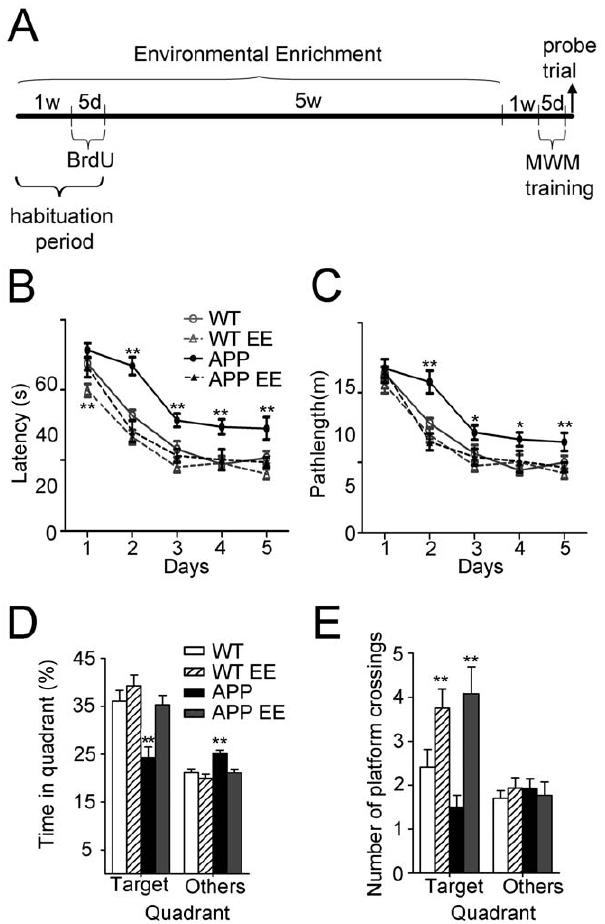
Figure 1. Short-term environmental enrichment improves learning and memory in young APP Sw,Ind mice. (A) The experimental design consisted of 7 weeks of environmental enrichment (EE), that included 5 days BrdU injections, and 1 week without enrichment followed by the Morris water maze (MWM). (B,C) The performance of WT (n=17), APP Sw,Ind (n=14) and 7 week-enriched WT (n=16) and APP Sw,Ind (n=14) mice at the age of 6 months improved significantly during the training days in the hidden version of the MWM, indicating that all groups were able to learn the task. Compared to WTs, APP Sw,Ind mice, but not enriched APP Sw,Ind mice, exhibited significantly longer latencies and pathlength from training day 2 to 5. (D) Percentage of time spent in the target and other quadrants during the probe trial on day 5 in the MWM. WT and APP Sw,Ind EE mice displayed significantly higher occupancy of the target quadrant relative to other quadrants ( p , 0.0001). (E) Number of platform crossings during the probe trial. EE increases the number of target platform crossings in both WT and APP Sw,Ind mice compared to standard housed mice. Significant differences were analyzed by two-way ANOVA. Data represent mean 6 SEM. **p , 0.05, **p , 0.01, compared to WT mice.